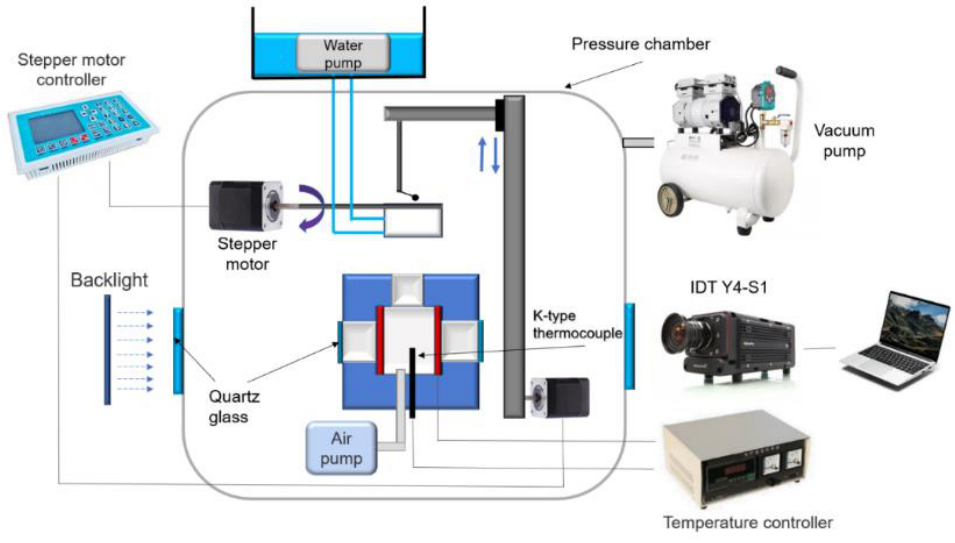
Figure 1. Schematic of experimental setup.